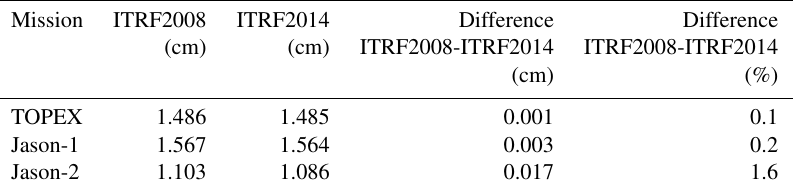
Table 5. Standard deviations of the radial errors obtained using orbits of three satellites based on ITRF2008 and ITRF20014 and their differences (positive values indicate improvements for orbits computed using ITRF2014).